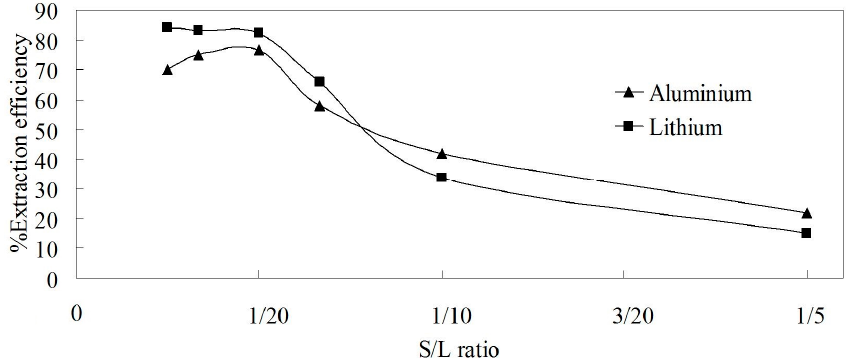
Figure 9. Effect of S/L ratio on the acid leaching of DCFA (6 mol/L HCl, 120 °C, 4 h).